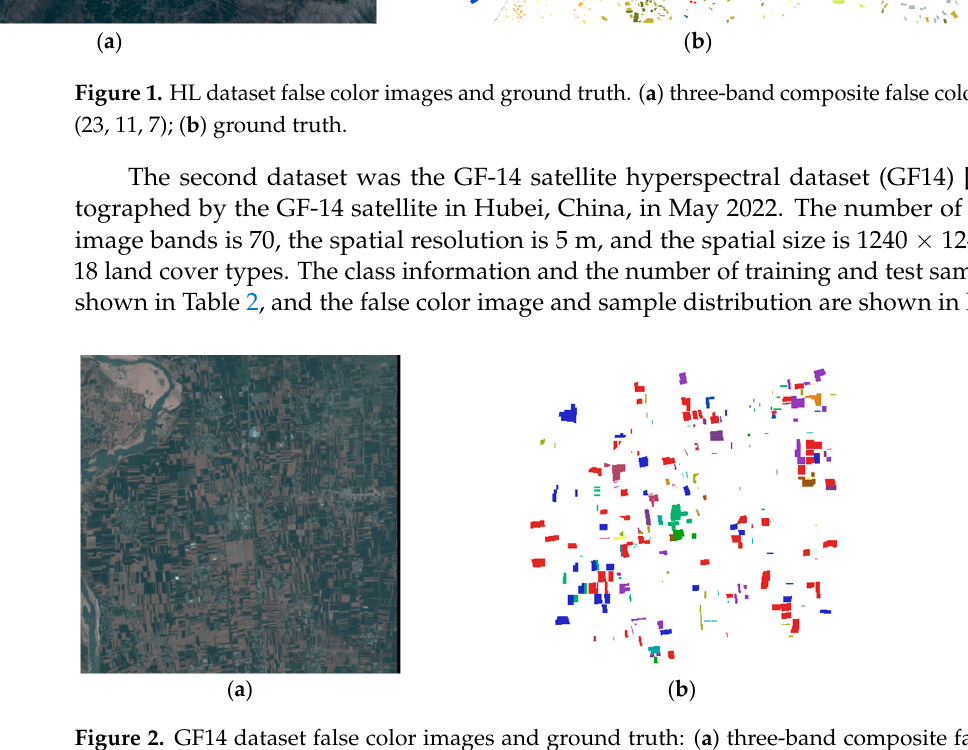
Figure 2. GF14 dataset false color images and ground truth: ( a ) three-band composite false color images (25, 11, 7); ( b ) ground truth. Table 1. Land cover classes with samples number for the HL dataset.